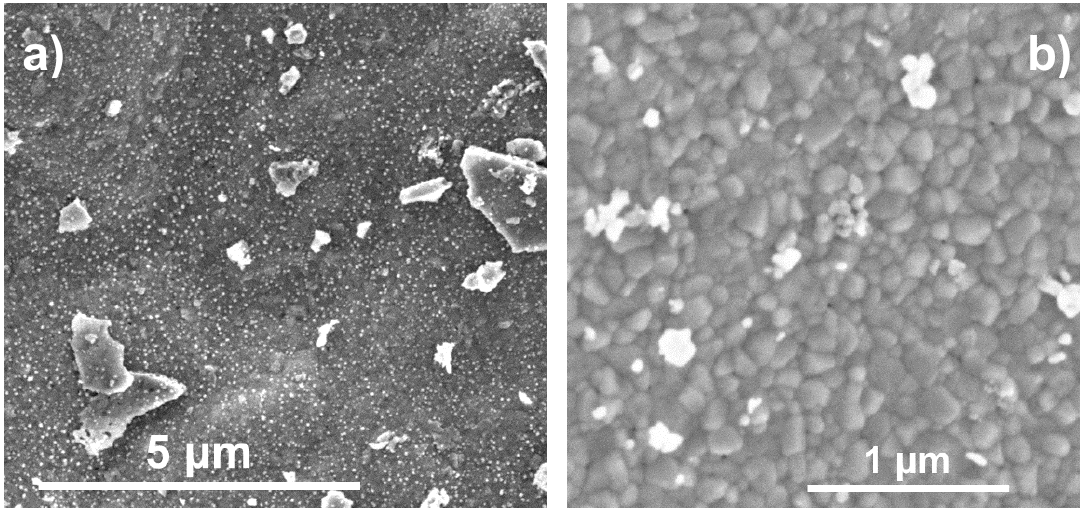
Figure 5. SEM image of ( a ) Nd 0.6 Ca 0.4 Fe 0.9 Co 0.1 O 3- δ and ( b ) Nd 0.9 Ca 0.1 FeO 3- δ after HT-WGS reaction. Formation of finely dispersed nanoparticles on the surface is visible in ( a ). The average size of the nanoparticles is between 30 and 65 nm. In image ( b ), only the crystallite structure of the perovskite is visible, but no exsolved nanoparticles can be observed for the undoped